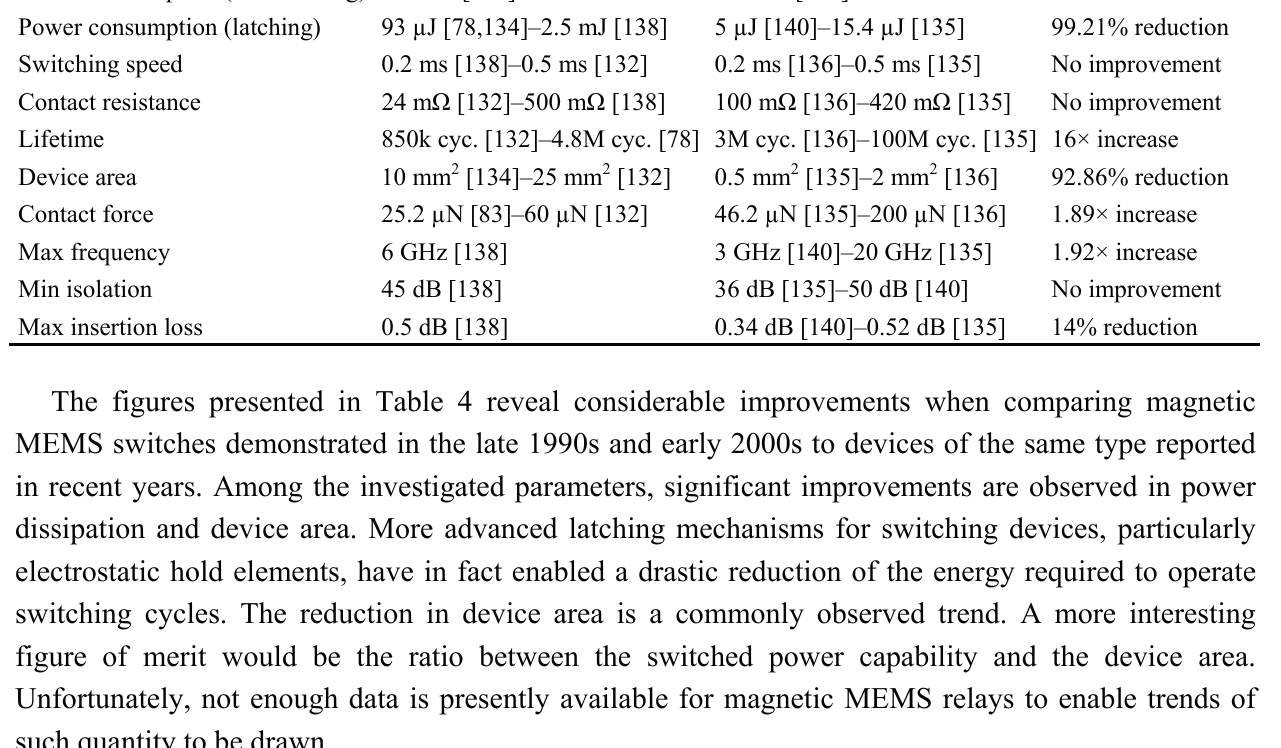
Table 4. Performance comparison between magnetic MEMS switches reported in the past decade. Benchmark